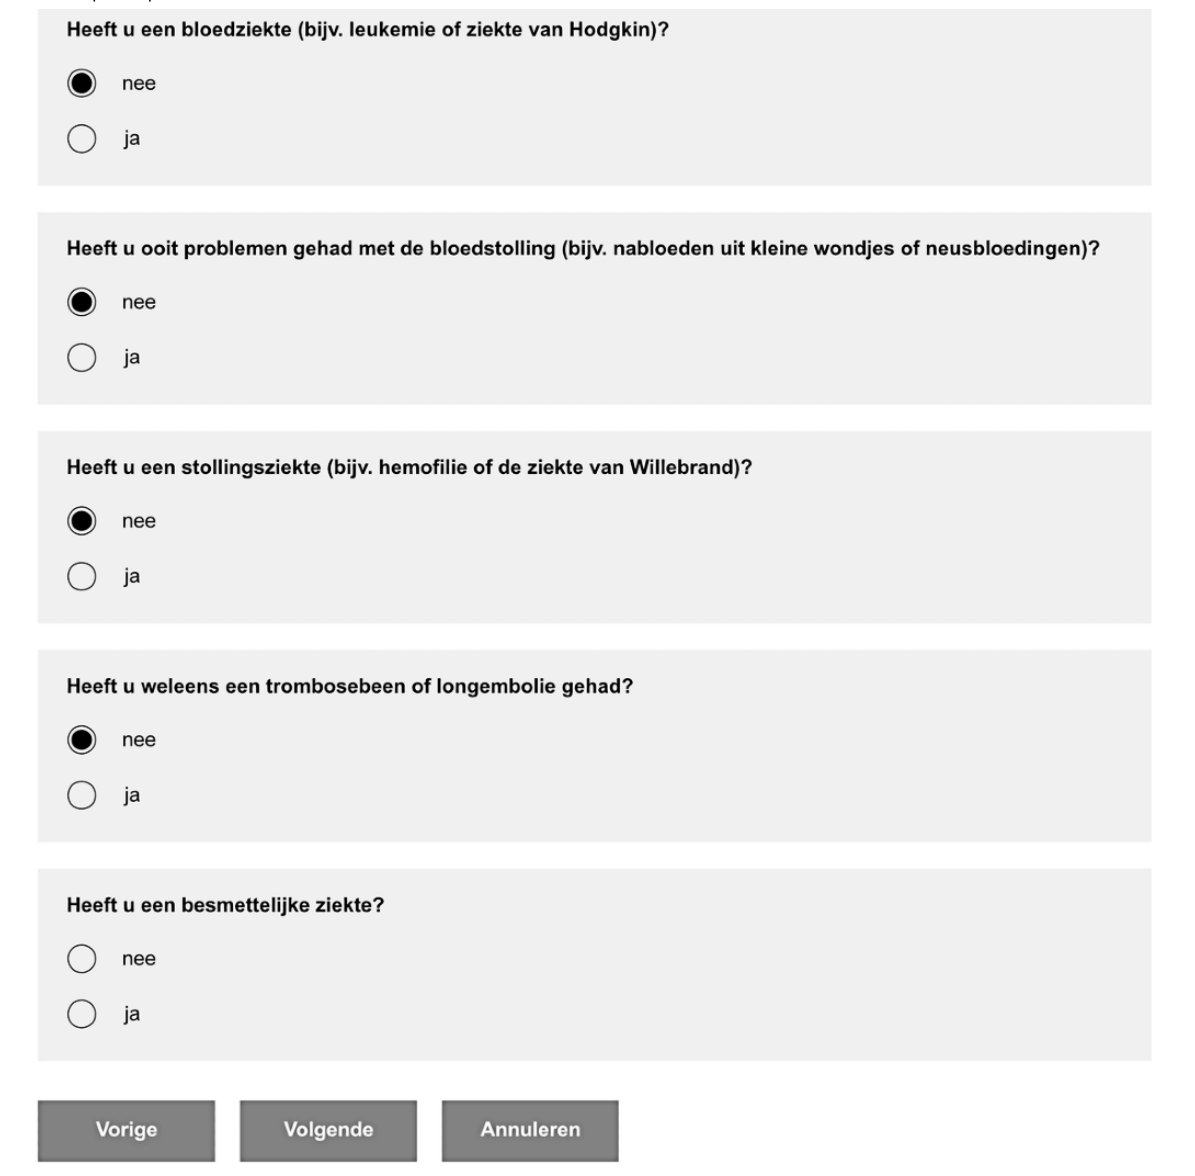
Figure 1. Computer